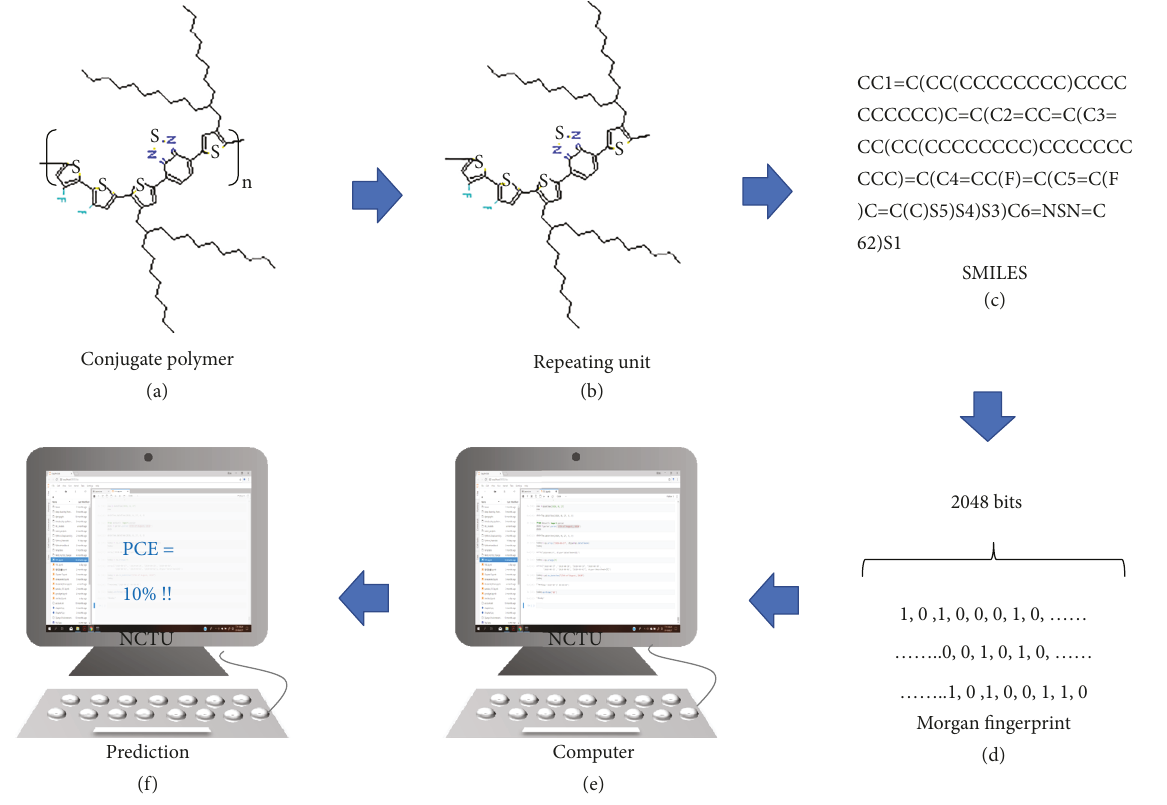
Figure 1: Schematic work fl ow of the machine learning for predicting the performance of conjugated polymers in OPV devices: (a) the chemical structure of the polymer; (b) the repeating unit; (c) the SMILES code; (d) the Morgan fi ngerprint; (e) the input of the dataset; (f) the resulting